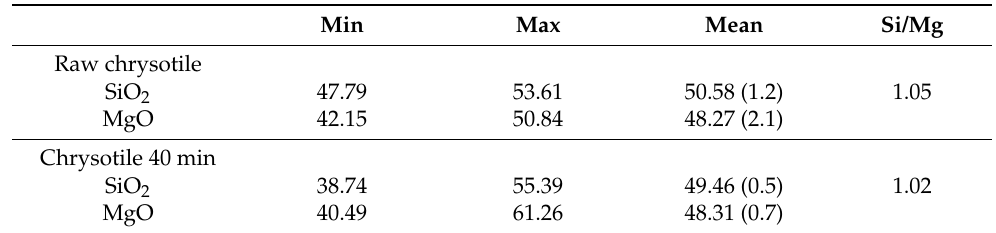
Figure 1. SEM images of Russian chrysotile. ( a ) An example of the long fibre bundles in raw chrysotile (CHR). ( b ) Detail of the bundle shown in ( a ) with intertwined fibres cluster. ( c ) Chrysotile after 5 min of milling (CHR5). ( d ) Chrysotile after 10 min of milling (CHR10). ( e ) Chrysotile after 20 min milling (CHR20); ( f ) Chrysotile after 30 min of milling (CHR30). ( g , h ) Chrysotile after 40 min of milling (CHR40). Table 3. Si and Mg content (expressed in terms of weight percent oxides) and Si/Mg ratio of raw and ground Russian chrysotile (40 min) fibres determined by 50 SEM-EDX spot analyses. Standard error of the mean in